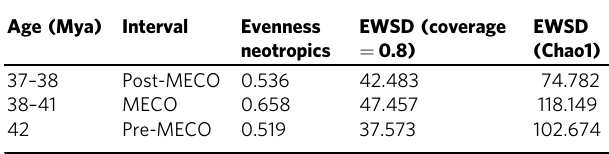
Table 2 Diversity estimates derived from spore-pollen records from Neotropics 11